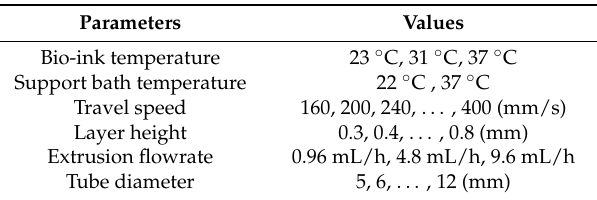
Table 1. Printing process